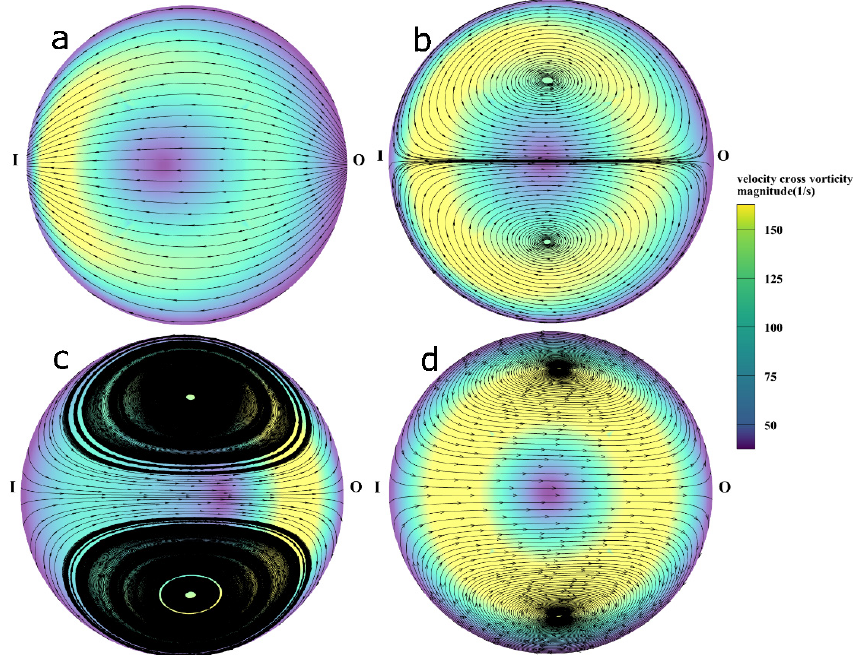
Figure 11. In the 45° channel at the conveying rate of 2.85 cm 3 /s, the profiles of the velocity cross vorticity magnitude and the projected streamlines. The slices ( a – d ) are from the second slice to the fifth slice shown in Figure 8a.